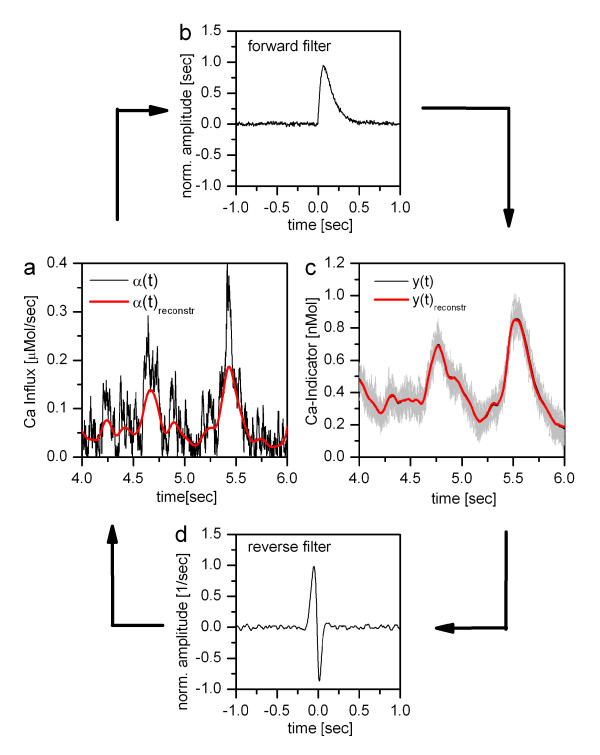
Reverse reconstruction of the calcium influx from the indicator signal. a: Calcium influx α(t) (in black) together with the reconstructed influx (in red). b: Optimal forward filter gforw(t). c: Average time course of calcium-bound indicator y(t) (in black), reconstructed signal (in red), and 12 individual indicator signals (in grey). d: Optimal reverse filter grev(t).